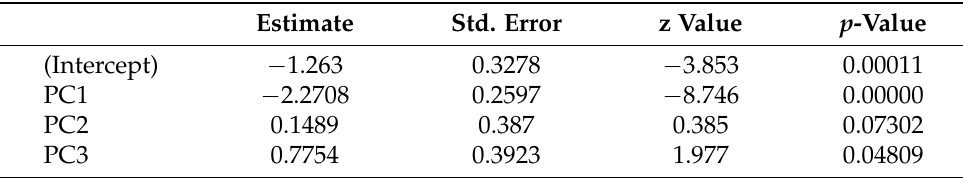
Table 4. Coefficient of principal components for the breast cancer data.